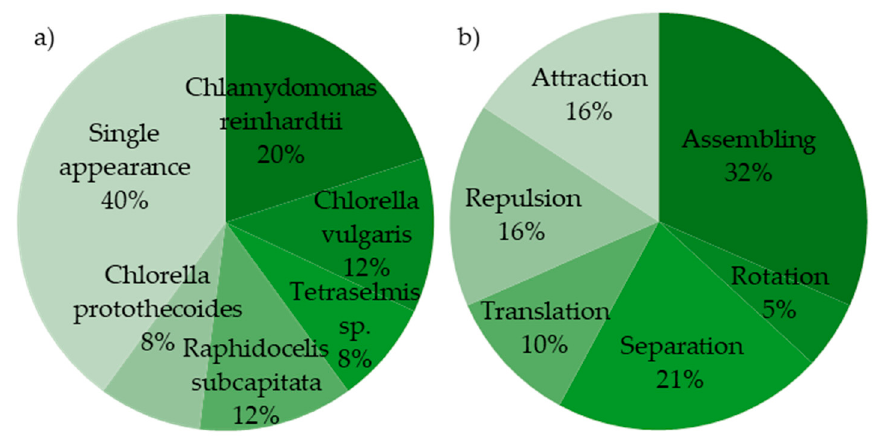
Figure 4. Overview of microalgae DEP research based on 16 publications (Table 1). ( a ) Used species of algae, ( b ) Application types of DEP in microalgae research.